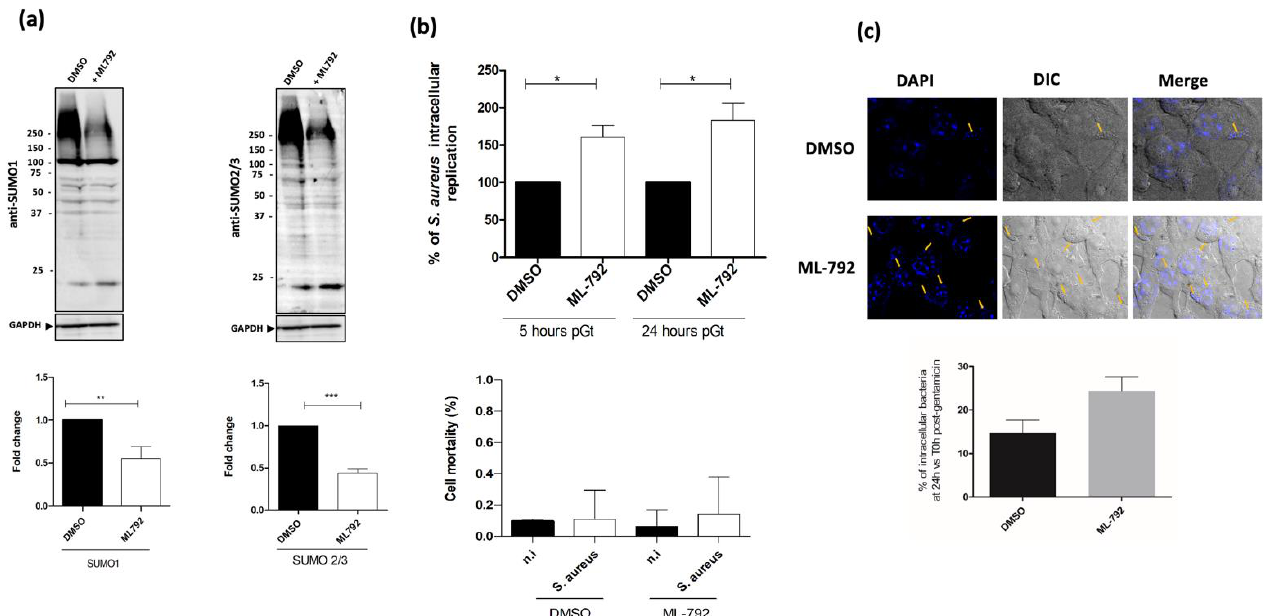
Figure 4 . SUMOylation inhibition increases the intracellular survival of S. aureus . ( a ) Immunoblot analysis of Raw264.7 macrophages were pretreated with ML-792 at 0.5 µM or DMSO as a control. SUMO1 and SUMO2/3 smears were quantified and normalized to GAPDH (bottom panels). ( b ) Macrophages pretreated with ML-792 at 0.5 µM or DMSO were infected with S. aureus . The number of intracellular bacteria recovered from macrophages after 5 h or 24 h post-gentamicin was counted and is presented as the ratio of intracellular bacteria compared to cells pretreated with DMSO, which is considered as 100%. Cell mortality was assessed using trypan blue exclusion dye 0.4% ( w/v ) to evaluate numbers of blue (dead) cells. ( c ) Representative confocal images from cells infected with S. aureus NSA739 for 24 h pGt using a 63-oil objective. Arrows show intracellular bacteria. The percentage of intracellular bacteria in pretreated cells with ML-792 is represented as the ratio of intracellular bacteria from ML-792 pretreated cells over DMSO-pretreated cells at 24 h pGt. The quantification is the result of independent counting of 100 cells from each of three independent experiments. DIC: differential interference contrast. *** p ≤ 0.001; ** p ≤ 0.01; * p ≤ 0.05 by one - way ANOVA with Bonferroni’s multiple -comparison test .